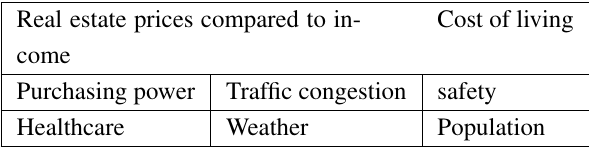
Table 2. Measuring Quality of Life through the Numbeo Indicator